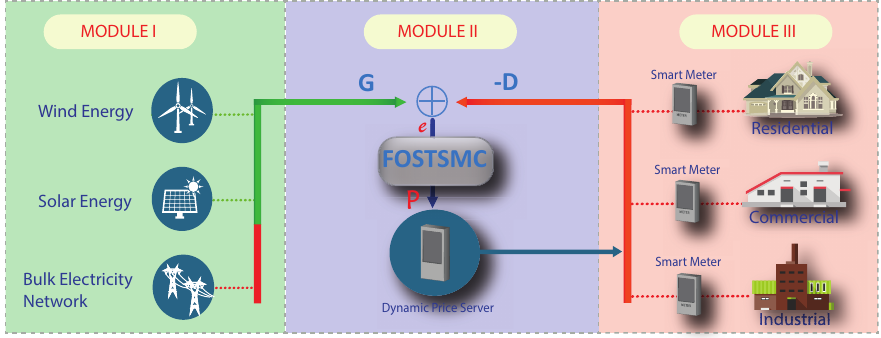
Figure 1. Schematic diagram of our proposed framework for implementation in a scenario. The difference (error ‘ e ’) between the instant energy demand and energy